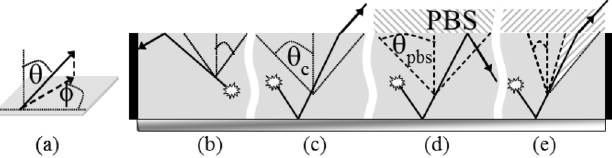
Fig. 3. Light guiding behavior of a fluorescent collector cov- ered with solar cells at the sides and a mirror at its back side. (a) Definition of photon ray angle θ . (b) Absorbed photons